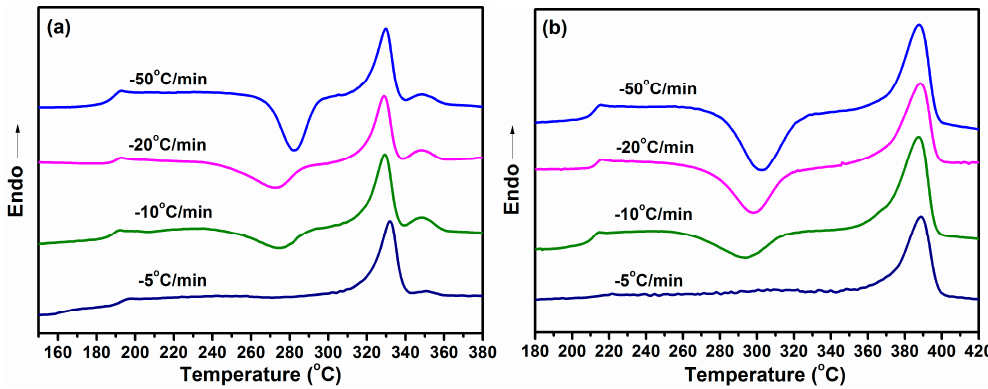
Figure 5. DSC scans for samples subjected to various cooling rates from the melt: ( a ) PI-1; ( b ) PI-2.